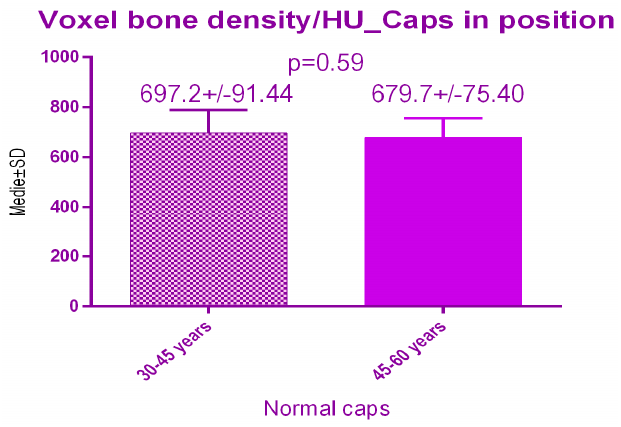
Figure 15. Bone radiodensity comparison by age after conventional healing caps.